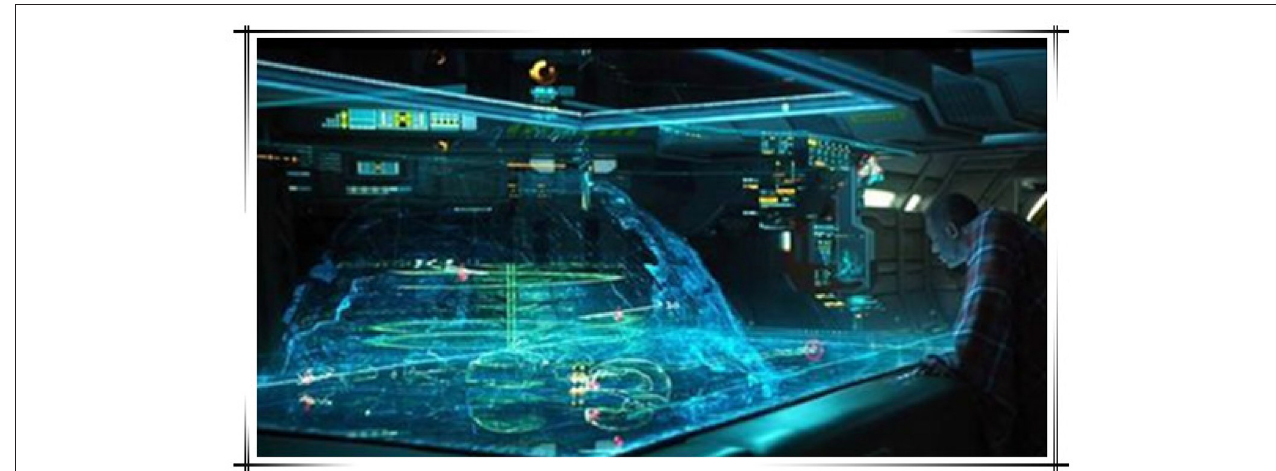
FIGURE 7 | Technological innovation of information industry (http://alturl.com/knbeo).